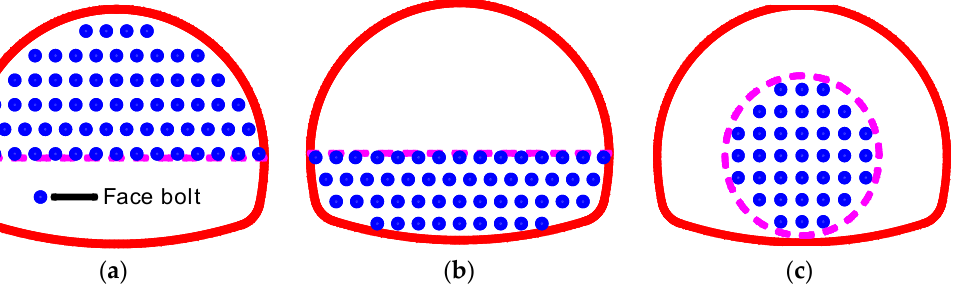
Figure 17. Different reinforcement range. ( a ) Upper reinforcement. ( b ) Lower reinforcement. ( c ) Central round reinforcement.